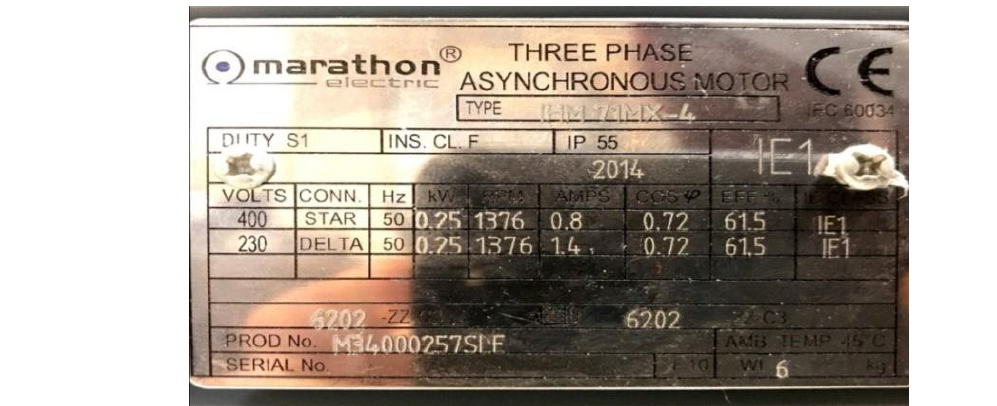
FIG.23. EXPERIMENTAL LABORATORY SETUP